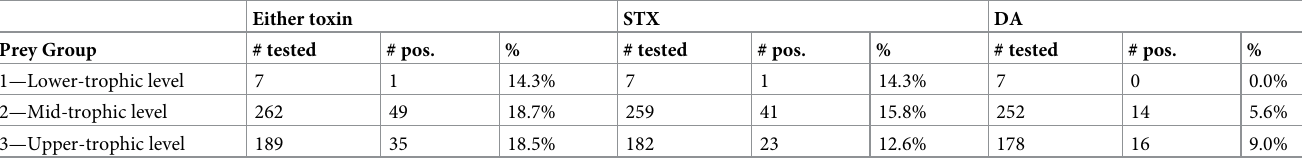
Table 8. Frequency of toxin-positive animals by dietary